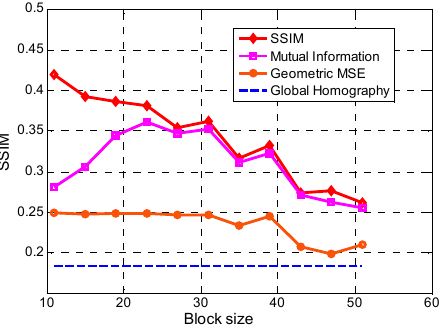
Figure 10. Global SSIM between transformed and reference images vs. block size for different metrics in blockwise local refinement, namely SSIM, mutual information, and geometric MSE.